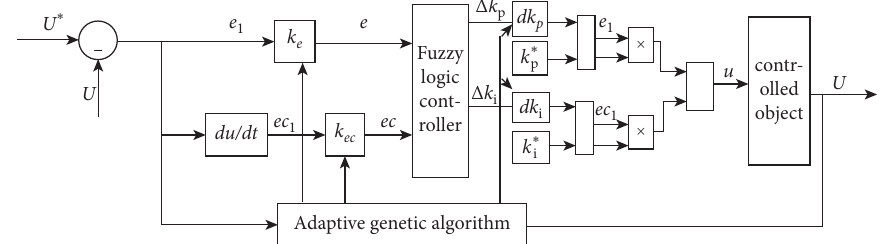
p surface graph. (b) Input and output Δ